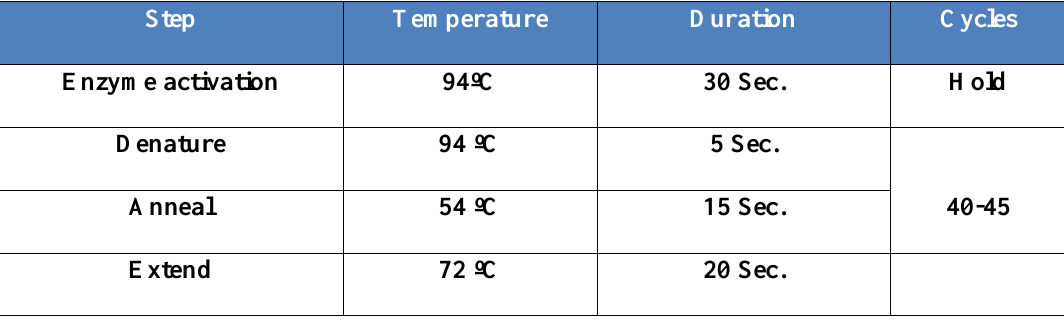
Table 3: Thermal profile used in allelic discrimination of IL-8